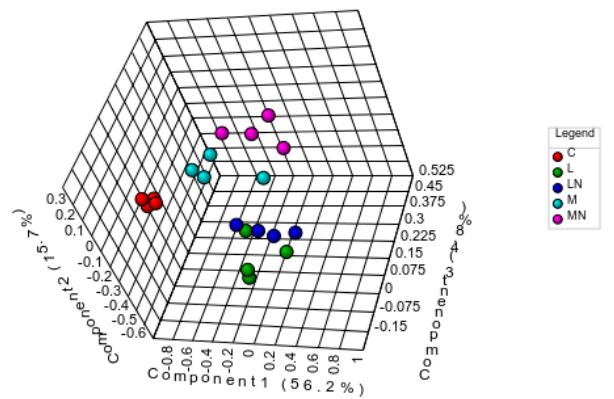
Figure 3. Partial least squares-discriminant analysis (PLS-DA) test (PC = 5) of all nano-LC-MS/MS quantified proteins. The 3D-plot shows biological replicates distribution considering the first three principal components. Control (C), L, LN, M and MN conditions are represented in red, green, dark blue, light blue and pink, respectively. Areas correspond to a 95% confidence region. Dots within each area represent the biological replicates of each exposure condition ( n = 4).